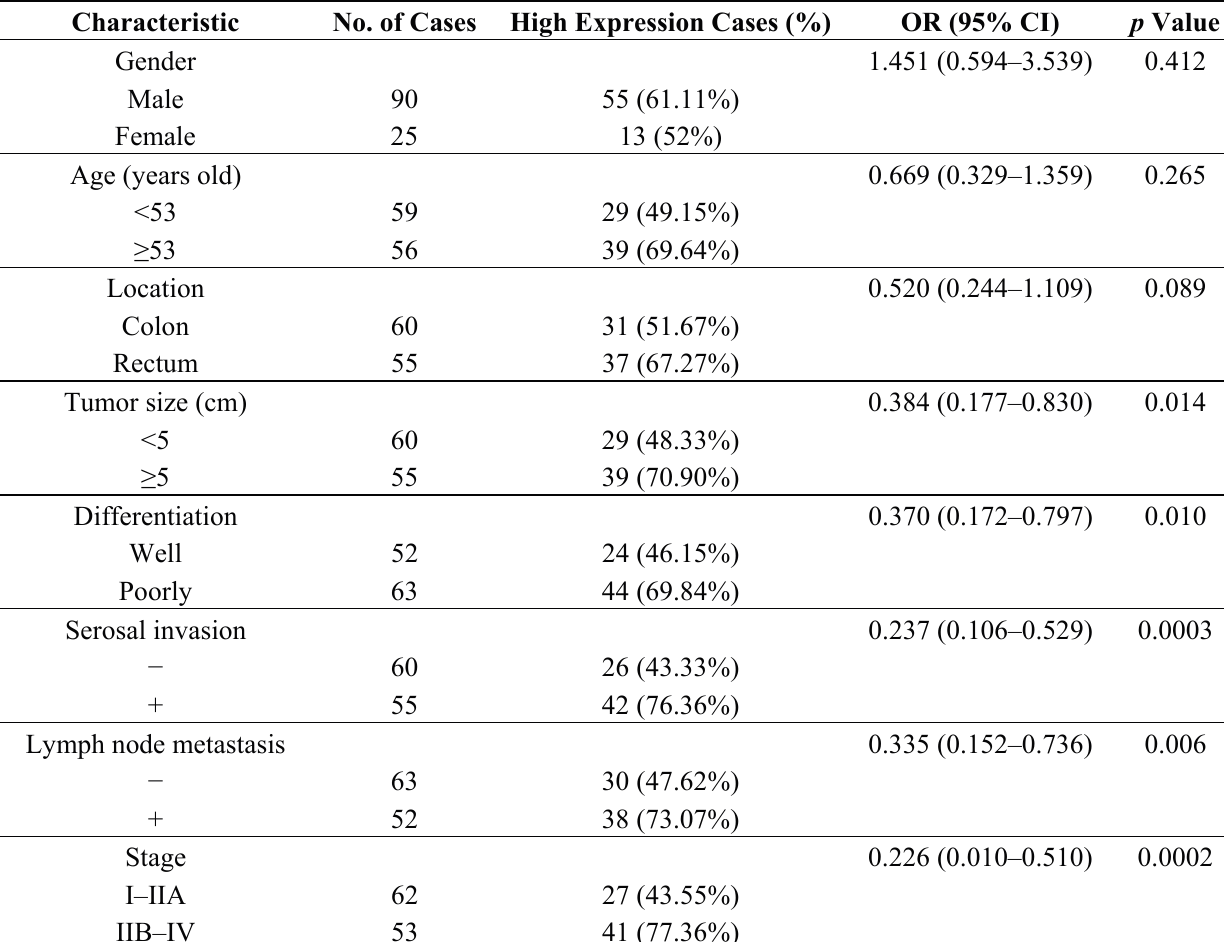
Table 1. POSTN expression and clinical-pathological characteristics in colorectal cancer patients ( n =